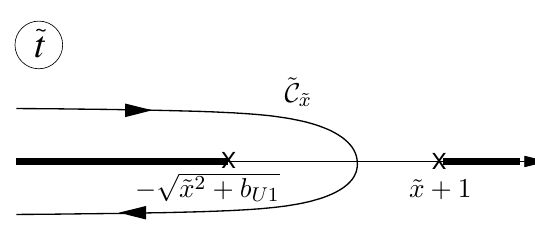
Figure 18. Time integration contour in eq.